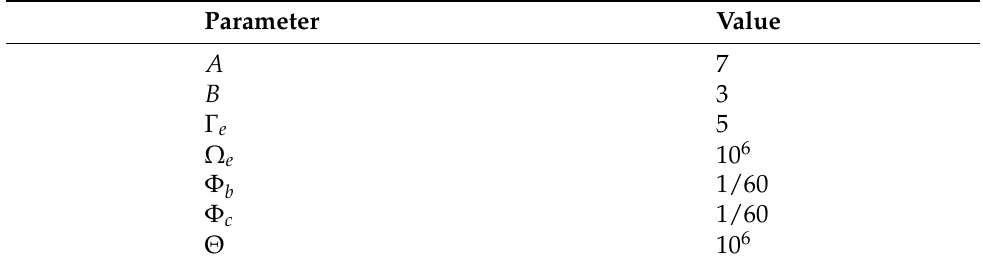
Table 4. Values of the used